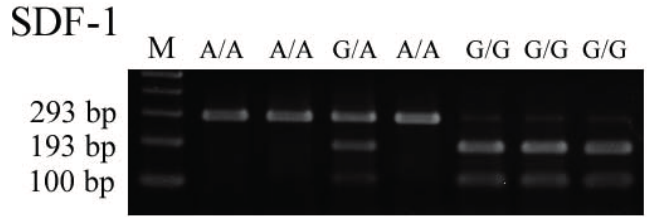
Figure 1. Wild type homozygous allele (G/G) yielded 100- and 193-bp products, the heterozygous alleles (G/A) yielded 100-, 193-, and 293-bp products, while the mutated type homozygous alleles (A/A) yielded a 293-bp